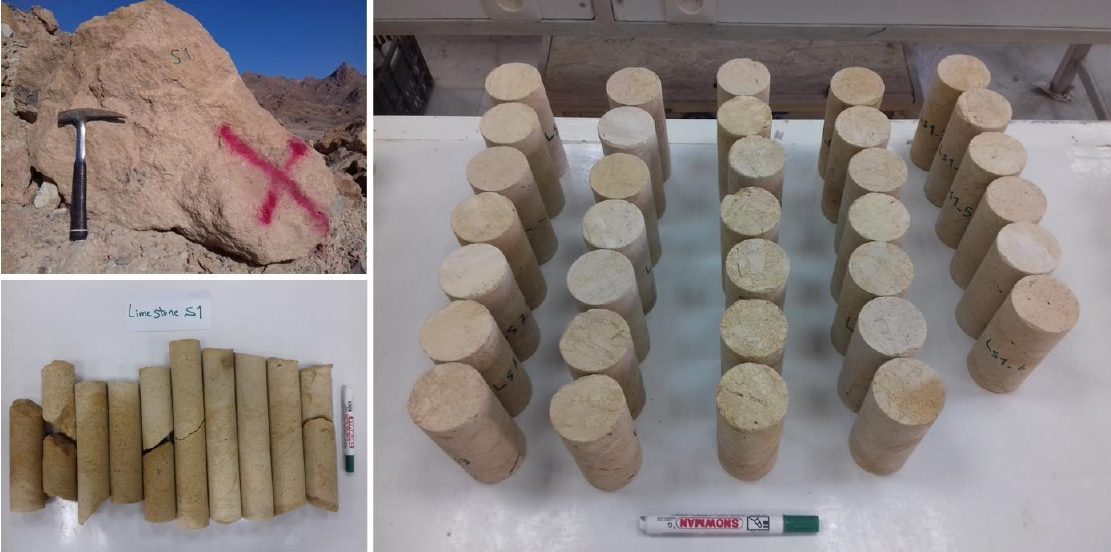
Figure 3. Block samples in the field and core specimens of the rocks.